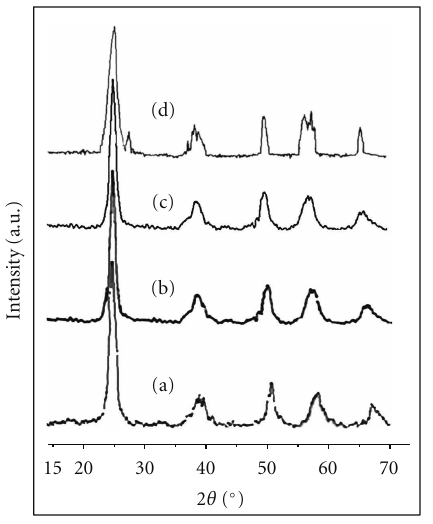
Figure 1: XRD patterns of (a) TiO 2 , (b) 1mol% Sn/TiO 2 , (c) 1.5mol% Sn/TiO 2 , (d) 3 mol% Sn/TiO 2